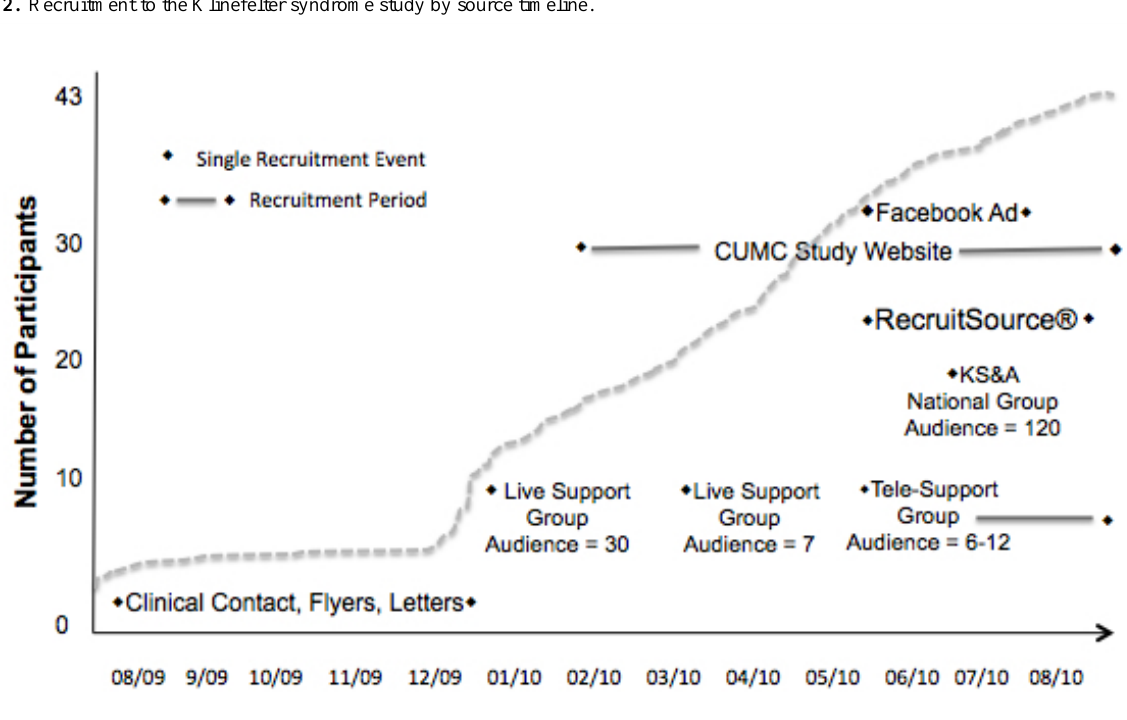
Figure 2. Recruitment to the Klinefelter syndrome study by source